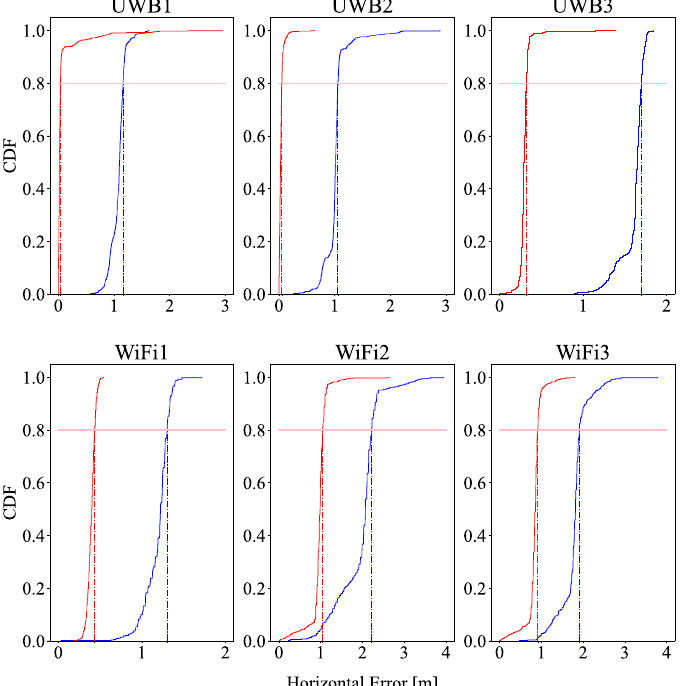
Figure 4. Ranging error of all the reference points with the UE under rubble (blue) and outside the rubble (red).